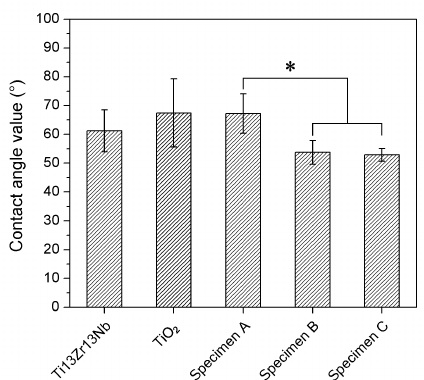
Figure 11. Water contact angle at room temperature for the reference non-coated specimen, TiO 2 layer, and chitosan composite coatings. Data are presented as the mean ± SD ( n = 3). * p < 0.05; one-way ANOVA with Bonferroni post hoc correction.